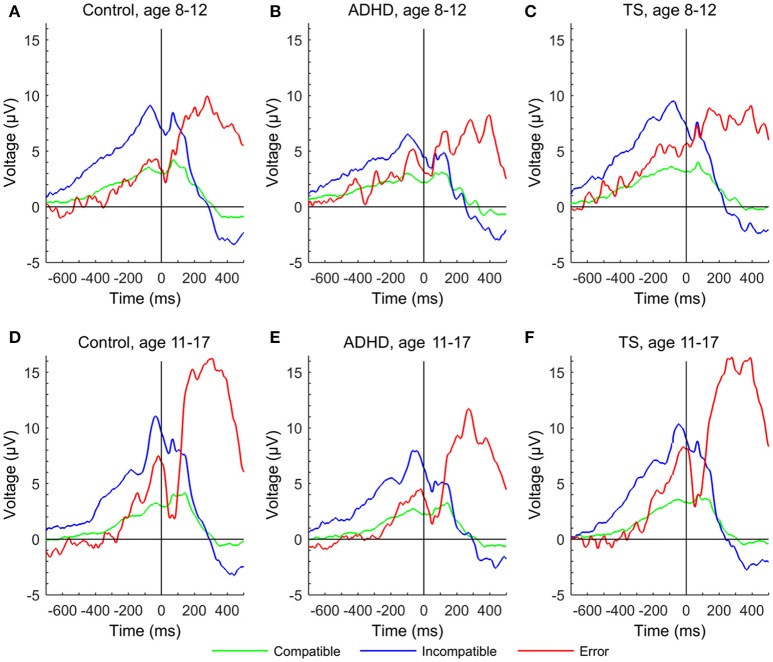
Error-related negativity and Pe in response-locked event-related potentials at a central region of interest to compatible (green), incompatible (blue), and erroneous trials (red) of the Flanker task for each group at first and second assessment. (A) control group at age 8–12 years, (D) control group at age 11–17 years, (B) ADHD group aged 8–12 years, (E) ADHD group aged 11–17 years, (C) TS group at age 8–12 years, (F) TS group at age 11–17 years.